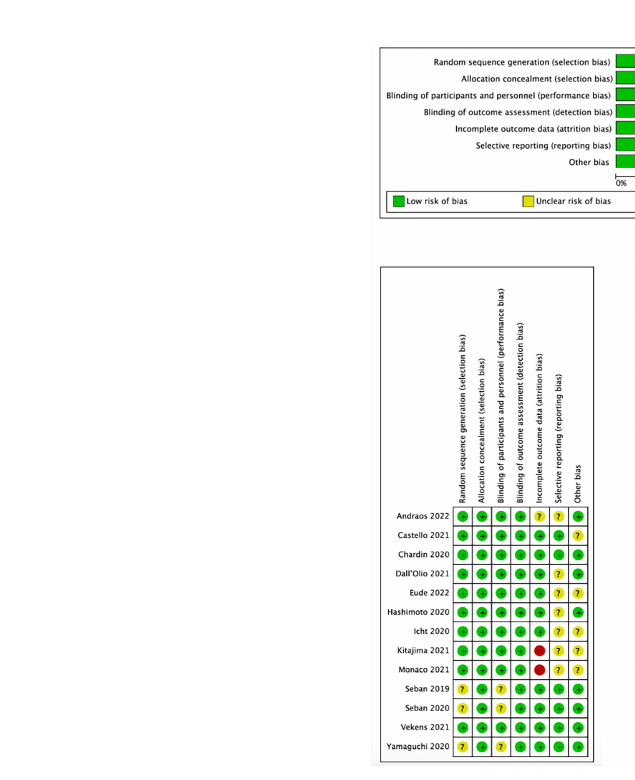
FIGURE 2 Results of quality assessment.